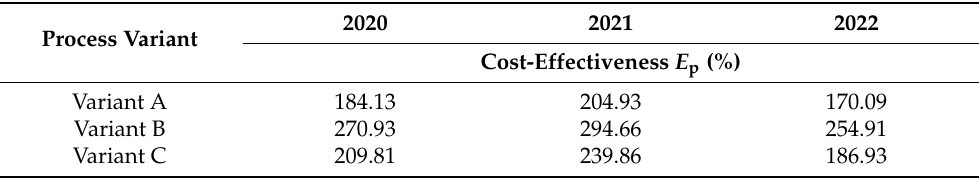
Table 12. List of efficiency indicators E p for sawing of pine lumber in 2020–2022.